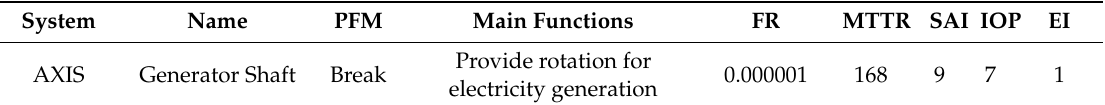
Table 1. Structure of the Failure Mode and E ff ects Analysis (FMEA)